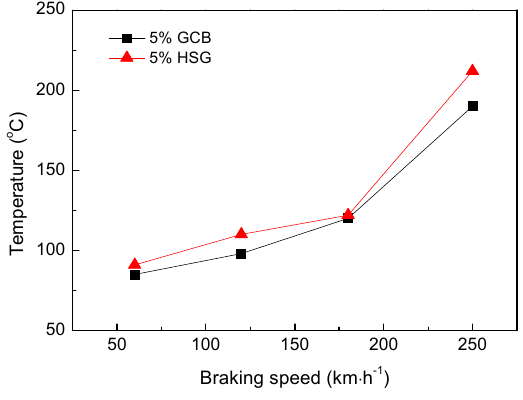
Figure 9. Effect of different lubricating phase on worn surface temperature of materials.